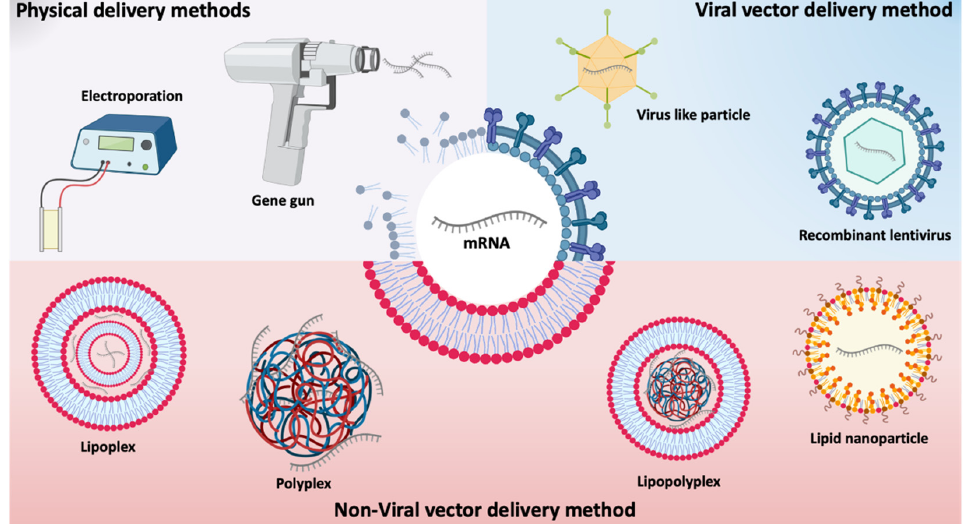
Figure 3. Schematic representation of different delivery strategies for mRNA therapies. There are represented 3 methods for the delivery of mRNA: physical methods, such as electroporation and gene gun; viral delivery systems, that uses recombinant virus; and non-viral delivery systems, such as lipid nanoparticles, polyplex, lipoplex and lipopolyplex.